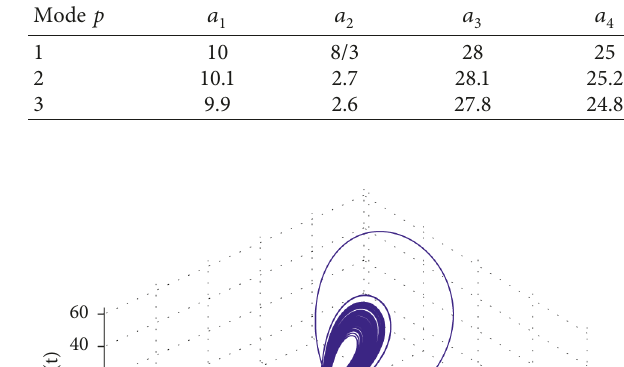
, a , a , and a for different modes in example 1. 1 2 3 4